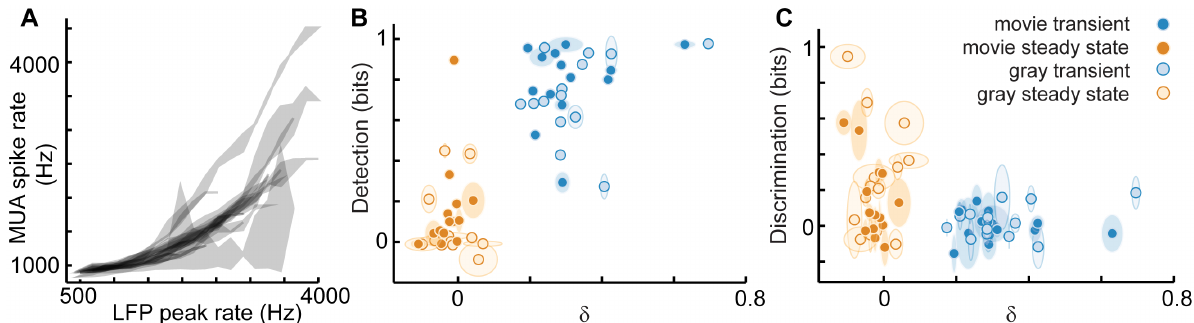
Fig 4. Adaptation enhances discrimination at the cost of reduced detection: MUA rate coding. ( A ) Based on the entire recordingfor each turtle, the LFP count per 1 second time windowis strongly correlatedwith the MUA spike count per 1 second. MUA was generally lower rate than LFP. Each shaded regioncorresponds to one experiment. The vertical extents of the shaded regionsdelineatequartiles. ( B ) Similar to our observationsbased on LFP peak response(Fig 3), we found that when response was definedbased on MUA spike counts, detectionis highest duringthe transient response and decreasesas adaptation progressesto a steady state. The decreasein detectionduringthe steady-state comparedwith LFP-based detectionis likely due to the lower activity rate of MUA relative to LFP. ( C ) MUA spike responsealso exhibitedincreaseddiscrimination duringthe steady state comparedwith the transient.